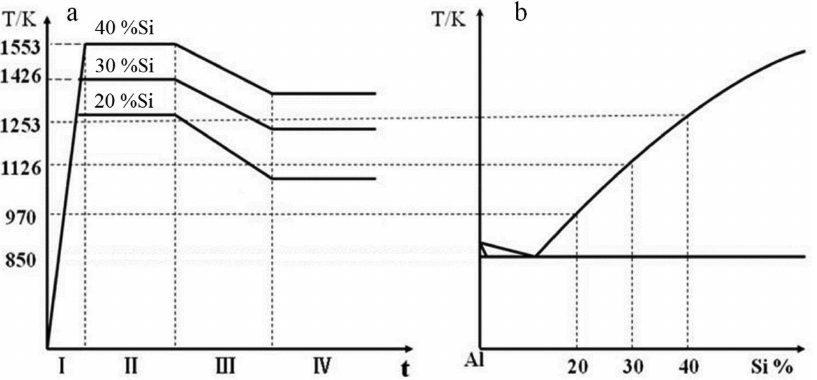
Figure 2: Temperature-time curves of different samples (a) Temperature (T) vs. time (t) curves during processing; (b) Al-Si phase